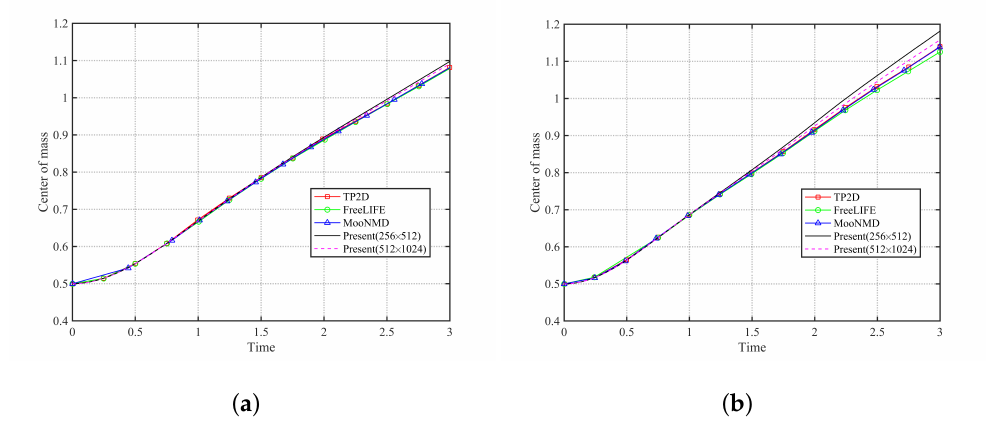
Figure 12. The evolution of the center of mass of the bubble compared with the reference results presented by Hysing et al. [49] for the two-dimensional rising bubble problem. The colors of the references indicate the results achieved with TP2D (solid red), FreeLIFE (solid green), and MooNMD (solid blue), as well as the 256 × 512 (solid black) grid and the 512 × 1024 (dashed pink) grid. ( a ) Case A. ( b ) Case B.